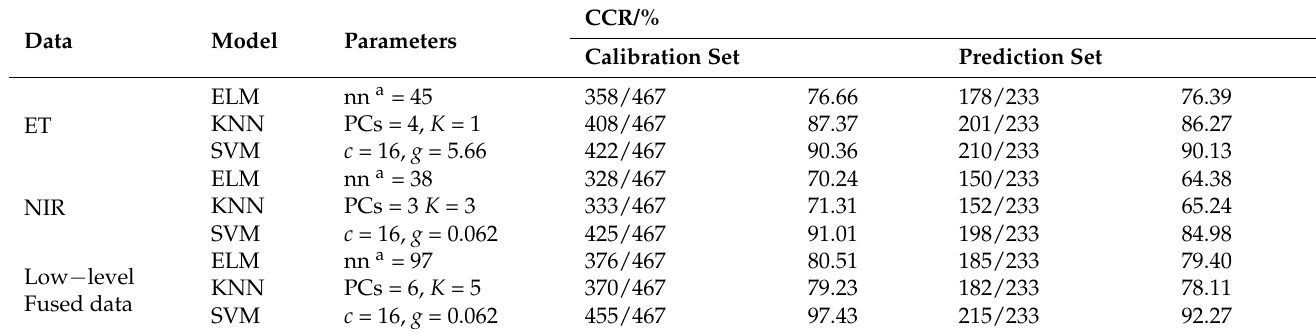
Table 2. Results of the optimal models based on ET sensors and spectral features combined with different chemometrics.